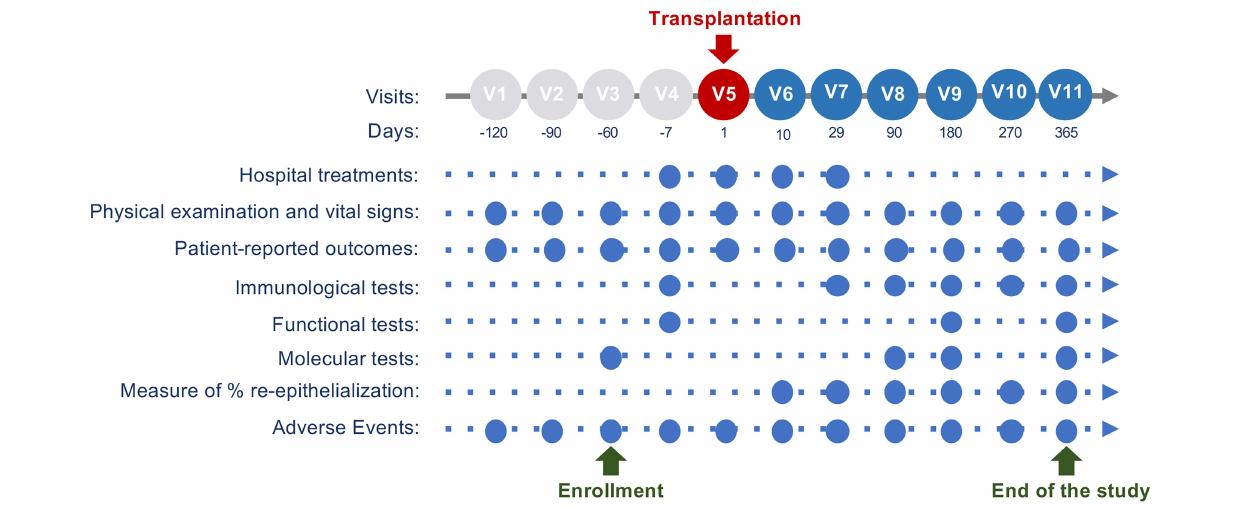
FIGURE 3 | Study visit schedule. This scheme describes the main activities performed at each visit. Pre-treatment phase is from approximately 6 months (V1) to approximately 7 days before the transplantation (V4). Hologene 5 transplantation will be performed during V5 (Day 1). Follow-up visits are planned from approximately 10 days after the grafting (V6) to the endpoint, 12 months after the transplantation